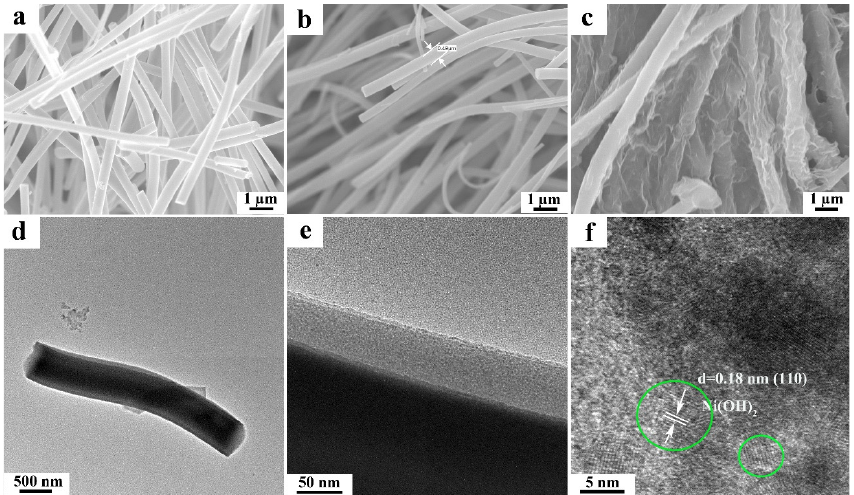
Figure 2. SEM, TEM, and high-resolution TEM (HRTEM) images of ( a ) TiO 2 fibers, ( b ) N-TiO 2 fibers, and ( c – f ) N-TiO 2 /1.0 wt% Ni(OH) 2 composite fi bers.